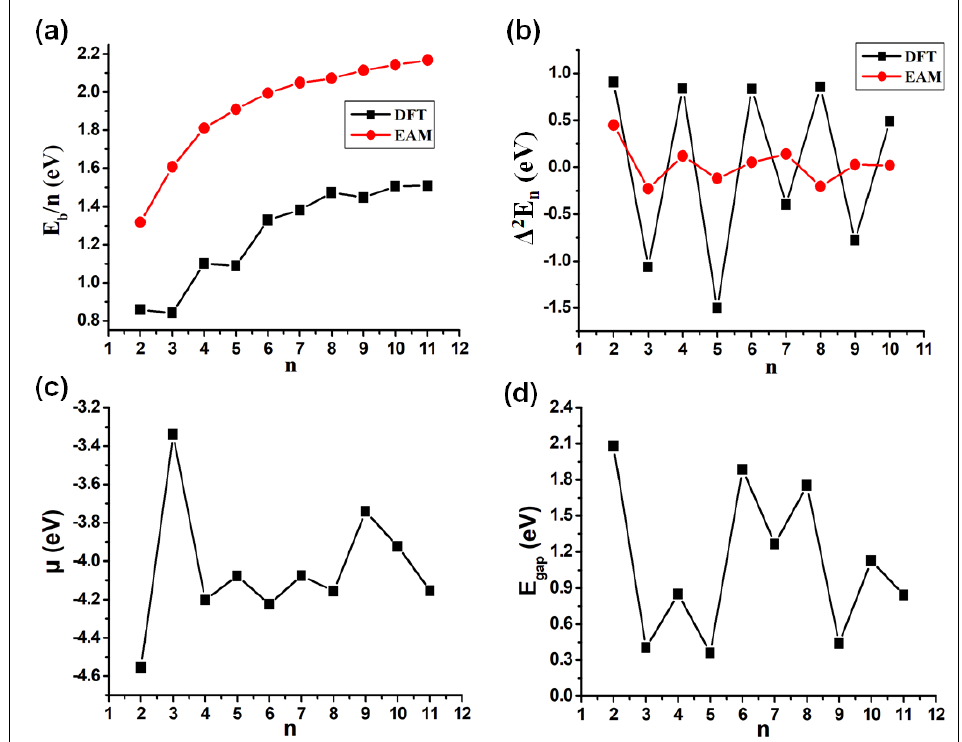
Figure 8. The variation of ( a ) E b / n , ( b ) ∆ 2 E n , ( c ) µ , and ( d ) E gap as a function of cluster size ( n ) as found in the DFT calculations and considering solely the energetically most stable isomer of these calculations. In ( a , b ) we also show the equivalent results from the EAM calculations (the red